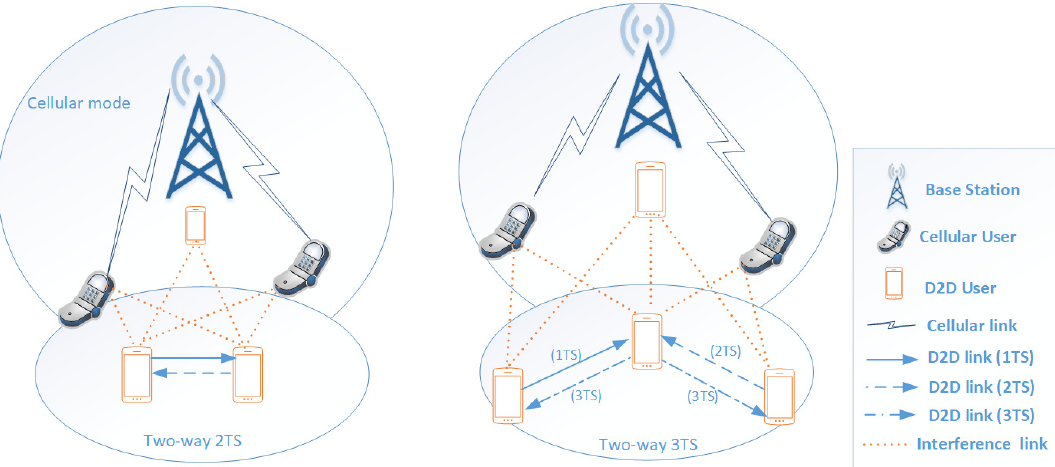
Figure 1. System